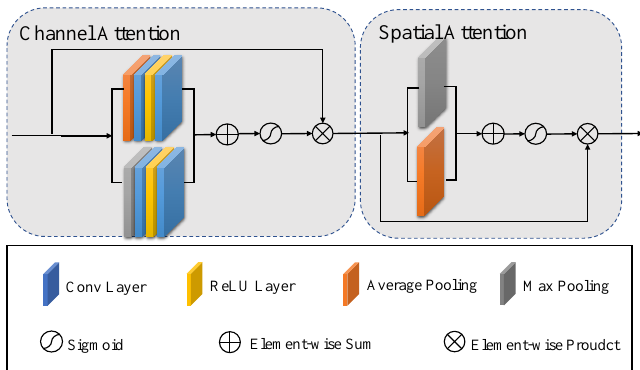
Figure 4. Attention Module framework